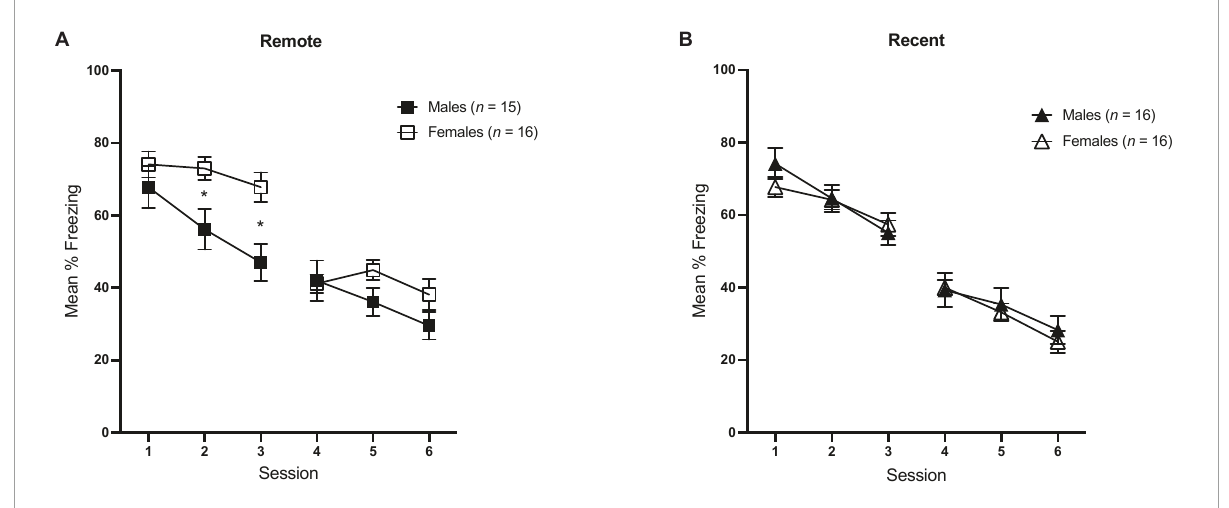
FIGURE5 Overall mean percent freezing ( ± SEM) during sessions of tone retrieval/extinction in the Remote [ (A) left] and Recent [ (B) right] groups. *Indicates significant with p <